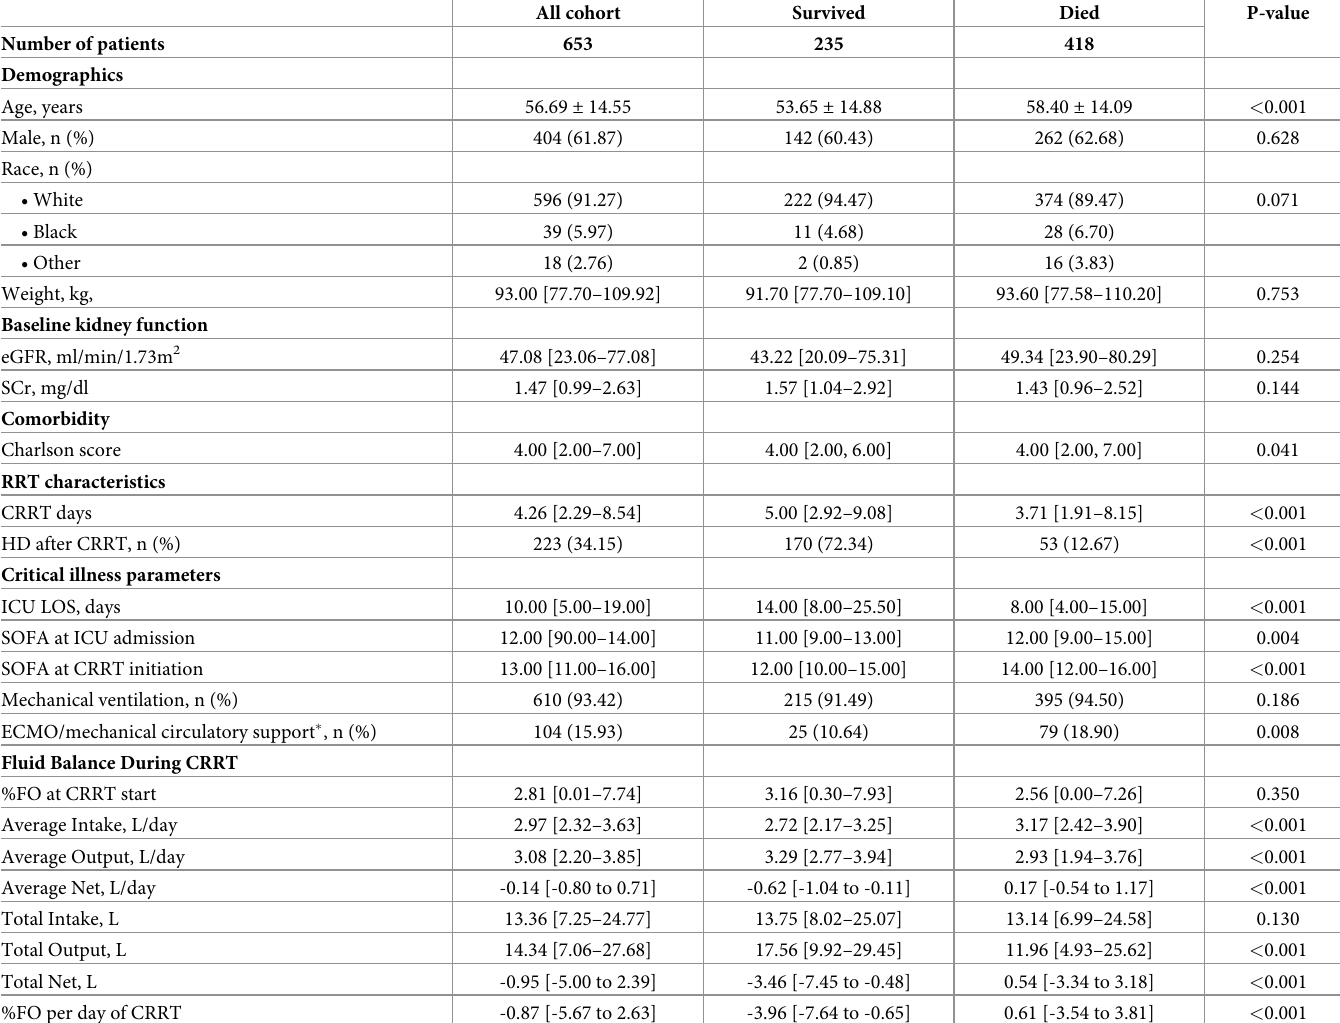
Table 1. Patient characteristics in the whole cohort and according to hospital